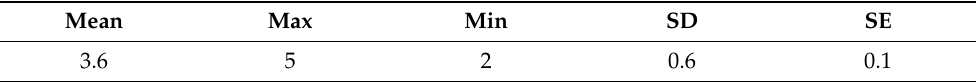
Table 6. Descriptive statistics for items regarding the existence of emotions in machines.